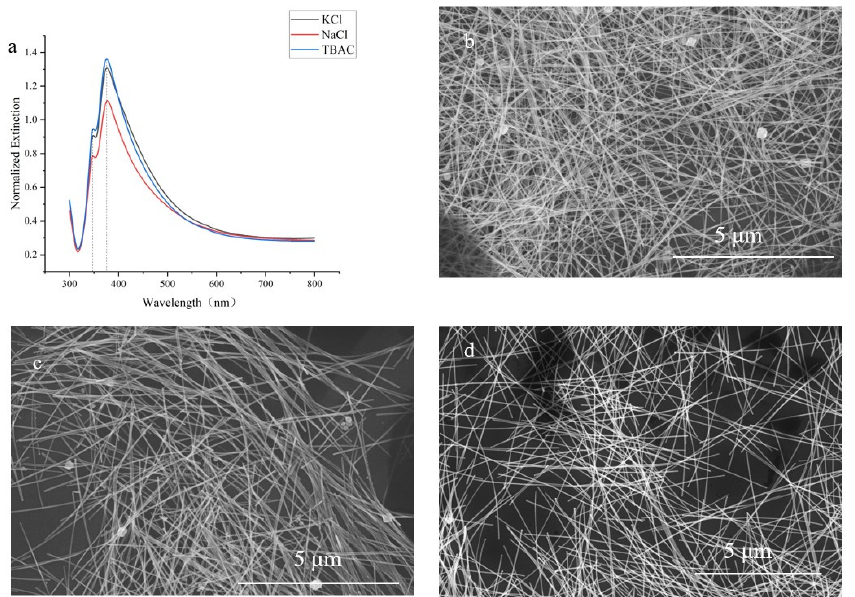
Figure 2. ( a ) Comparison of the extinction spectra. ( b – d ) SEM images of the crystal additives KCl, NaCl, and